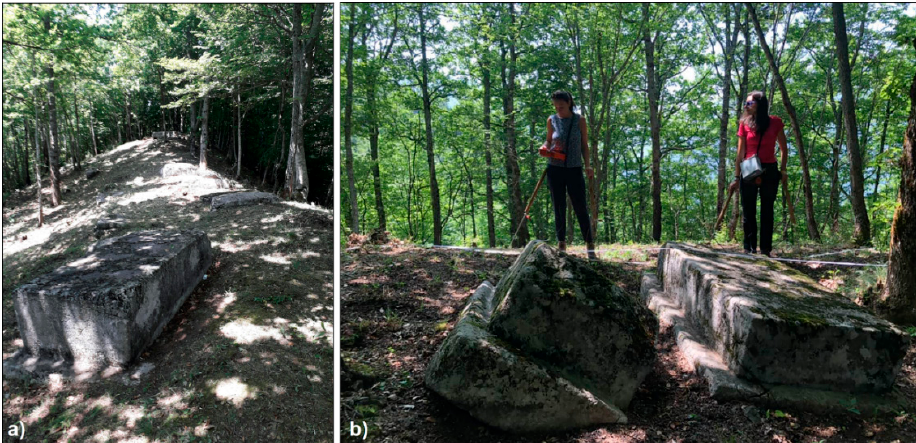
Figure 19. Ste ć ci of Plužine: the biggest tombstone that contains an inscription ( a ) and a moment of data acquisition ( b ).